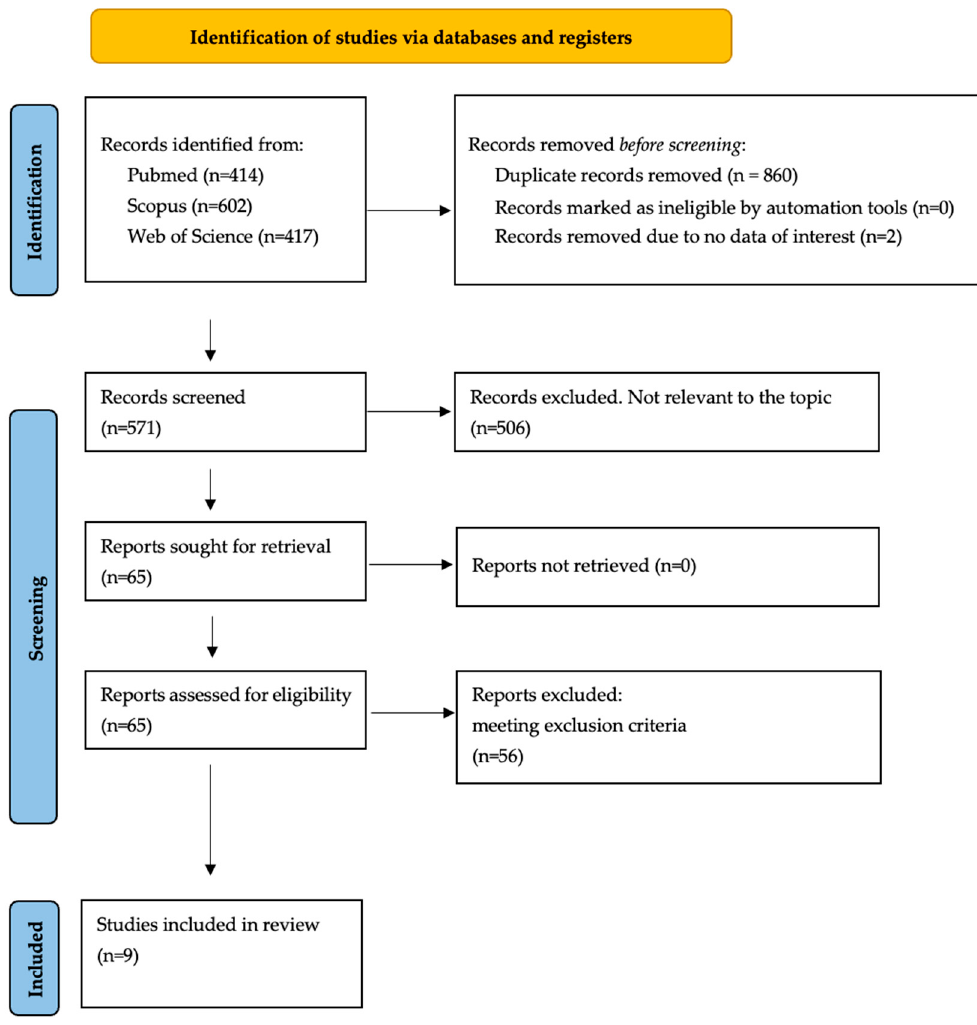
Figure 1. PRISMA flow diagram summarizing the literature review and inclusion/exclusion